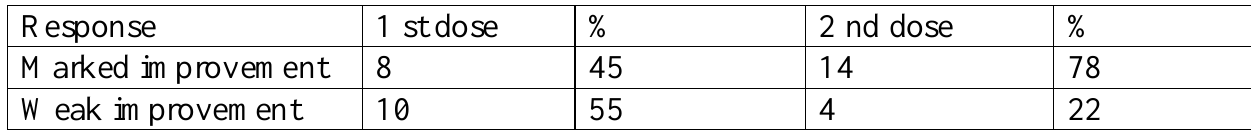
Table 3. The outcomes of 18 patients treated with 1st and 2nd doses of silver